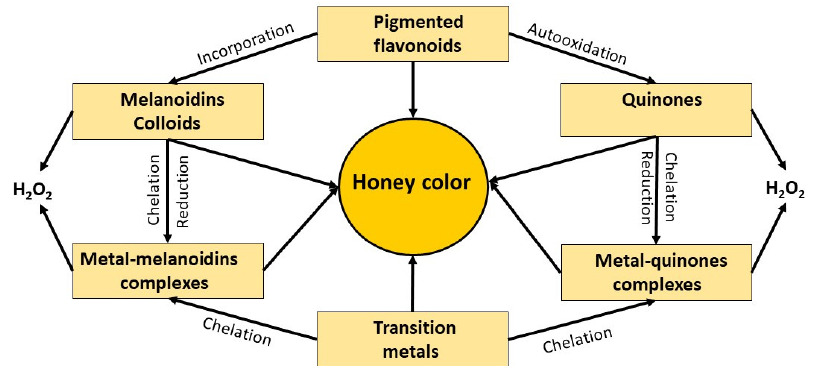
Figure 5. A diagram representing honey color as the direct result of the combine effect of the content of the color-impending compounds (flavonoids, quinones, transition metals) and the color-developing reactions (polyphenol autooxidation, quinone-protein conjugation, metal- quinone complexes, Maillard reactions and the formation of melanoidins and colloidal particles) and its indirect association with H 2 O 2 production.